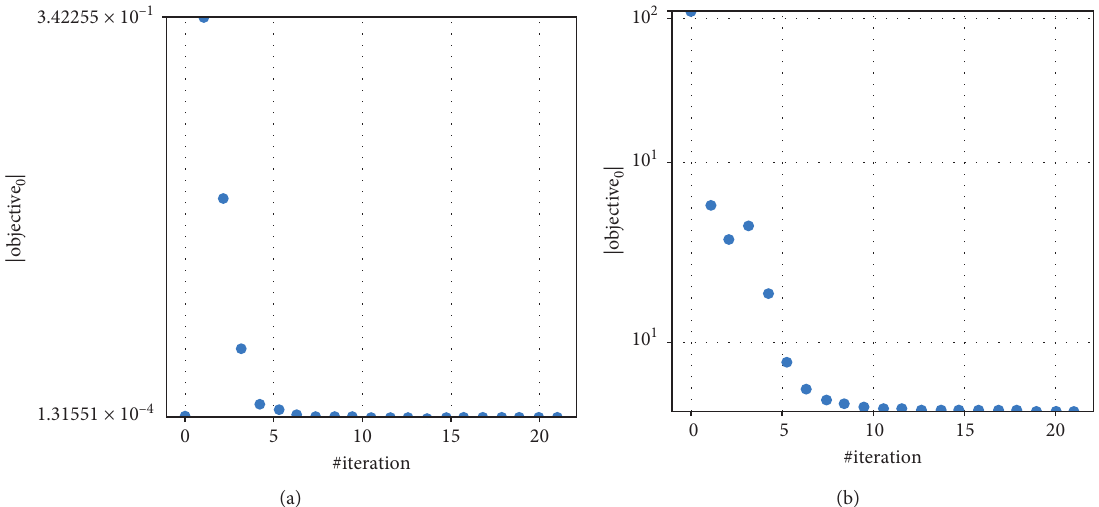
Figure 12: The effect of fine-tuning on the convergence rate of the method. Solving Example 3 with (a) fine-tuning and (b) without fine-